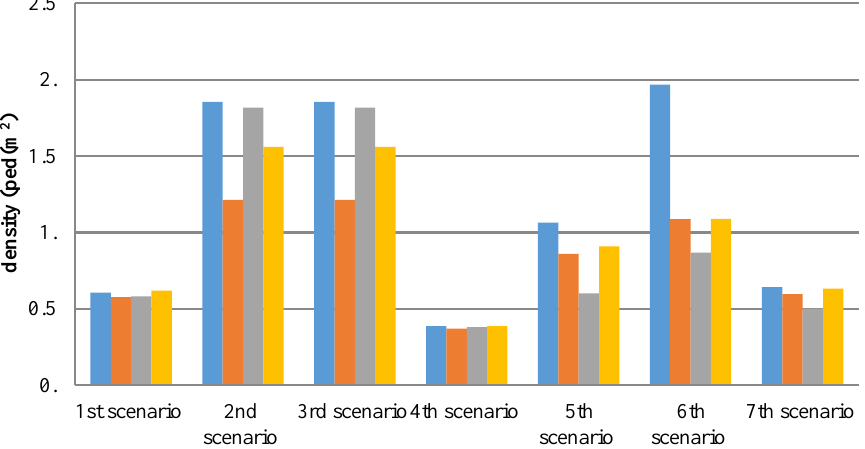
Figure 5. Density evaluation in accordance with different monitored scenarios.